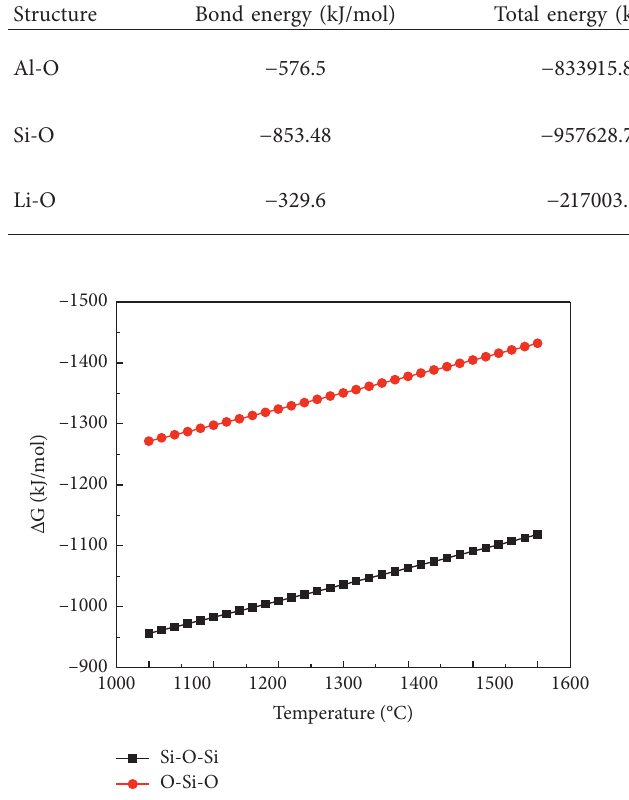
Figure 1: The change in ∆ G of Si-O-Si and O-Si-O structures with respect to temperature.